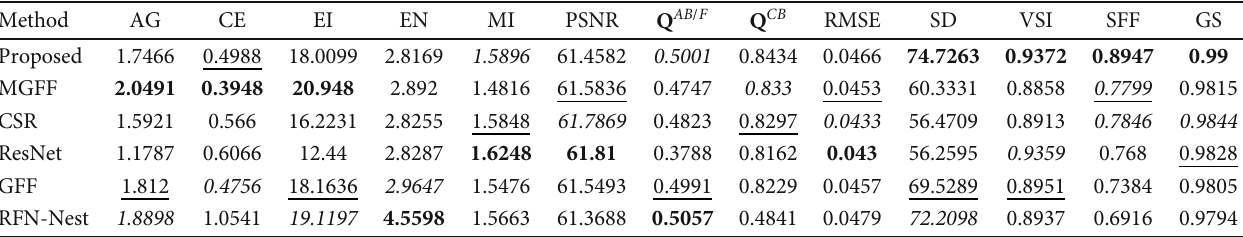
Figure 7: Fusion results of di ff erent methods in the weak illumination scene. Table 3: Average evaluation metric values of all methods for local illumination scene of the SDD dataset. The best three values of each metric are marked as bold, italic, and underlined.